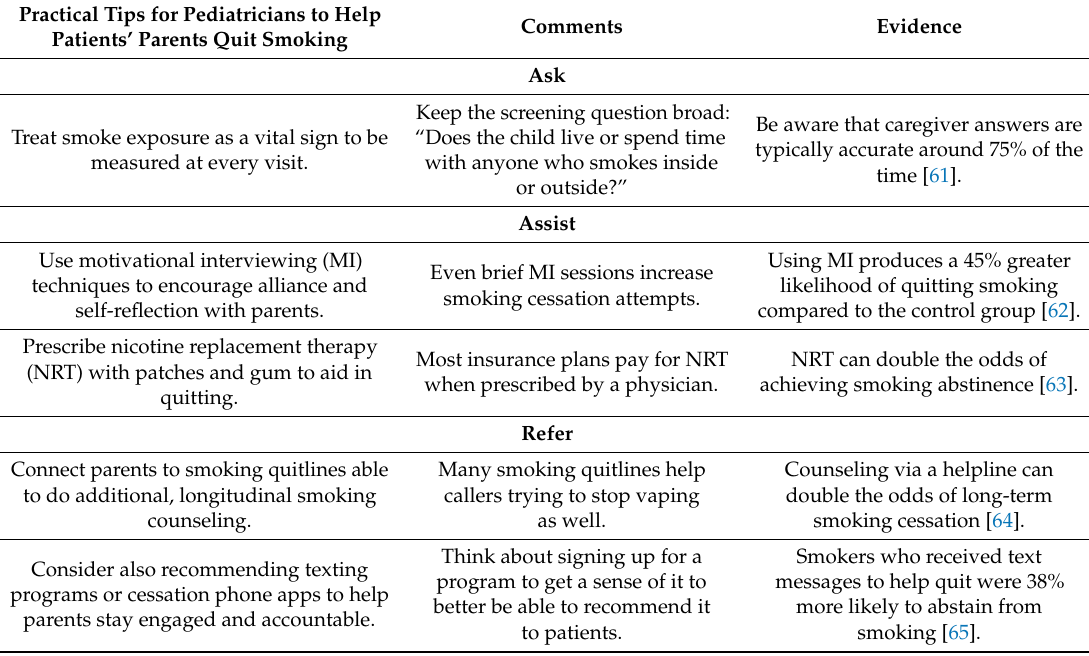
Table 3. Suggestions for Pediatricians to Help Parents/Caregivers Quit